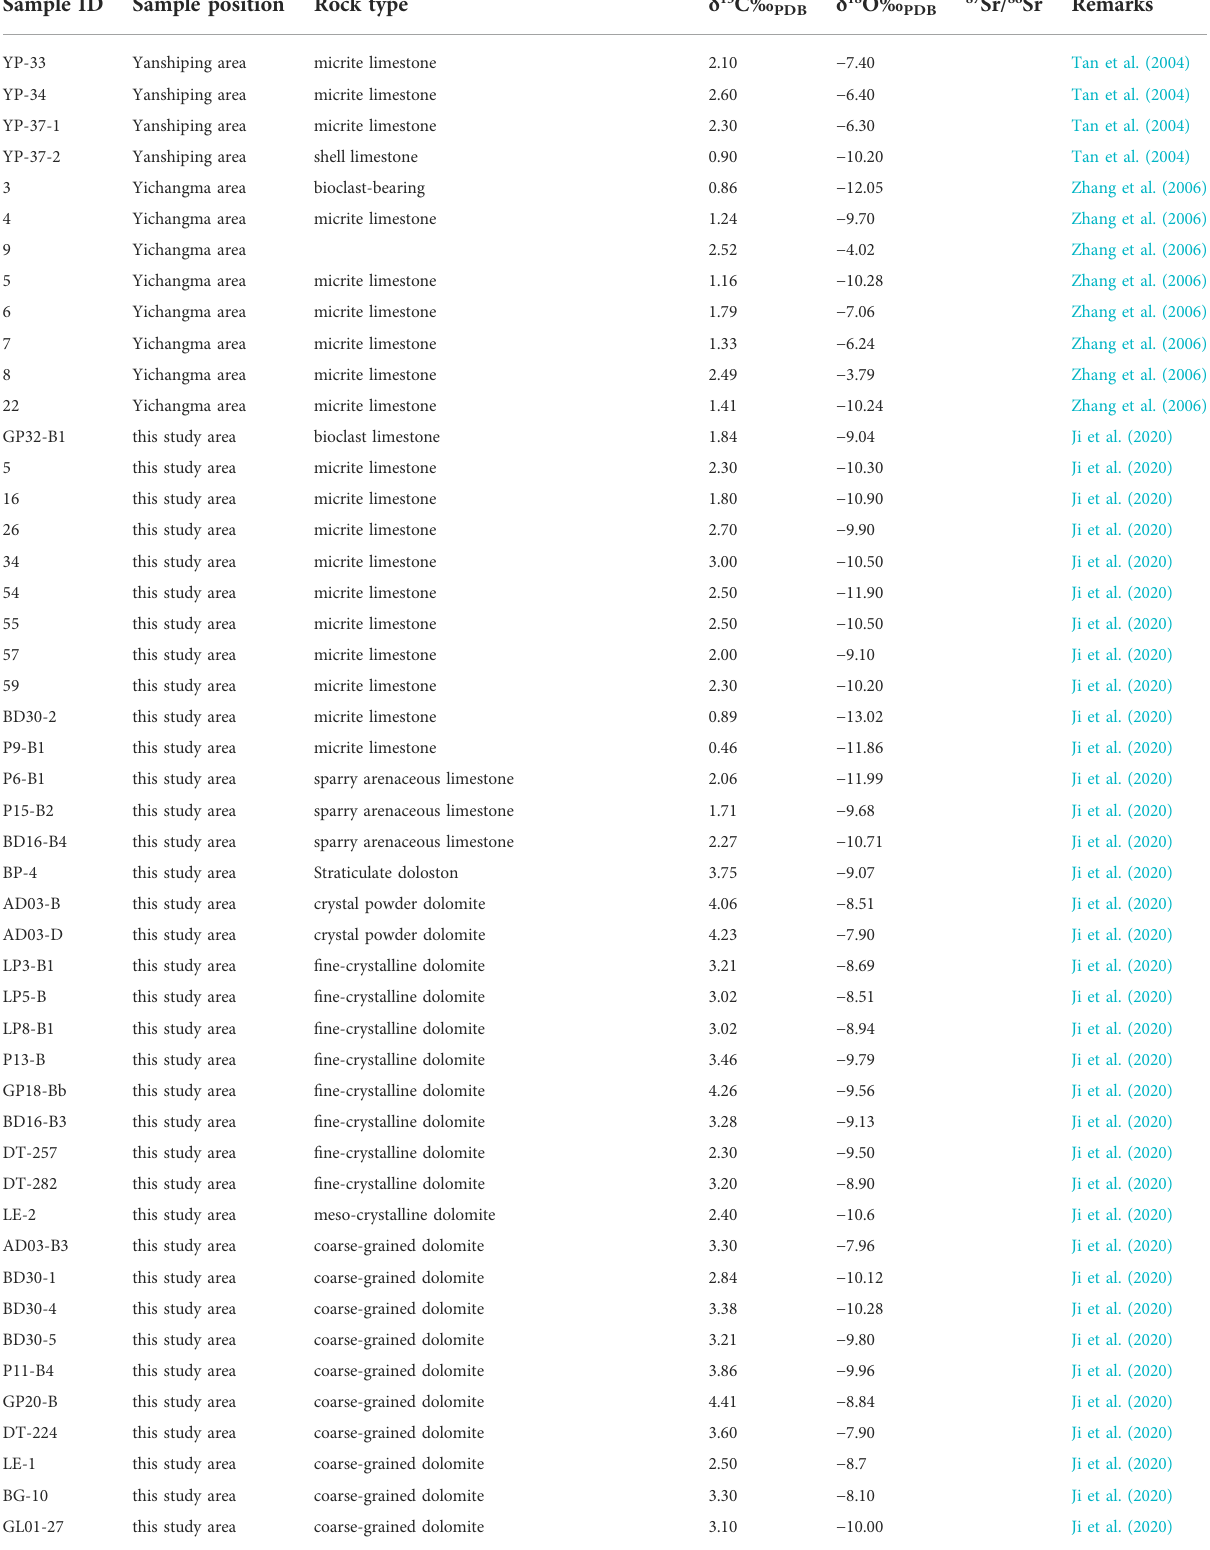
TABLE.3 C- O and Sr isotope data for the different carbonate rocks in the Buqu